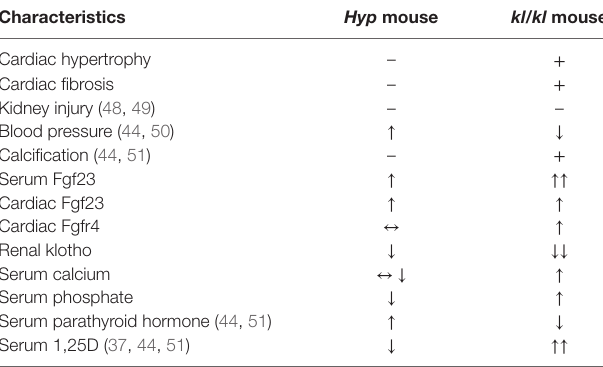
Table 2 | Differences between Hyp and kl/kl mice regarding characteristics of cardiovascular and kidney disease, cardiac FGF23/FGFR4 system, and parameters of mineral metabolism.